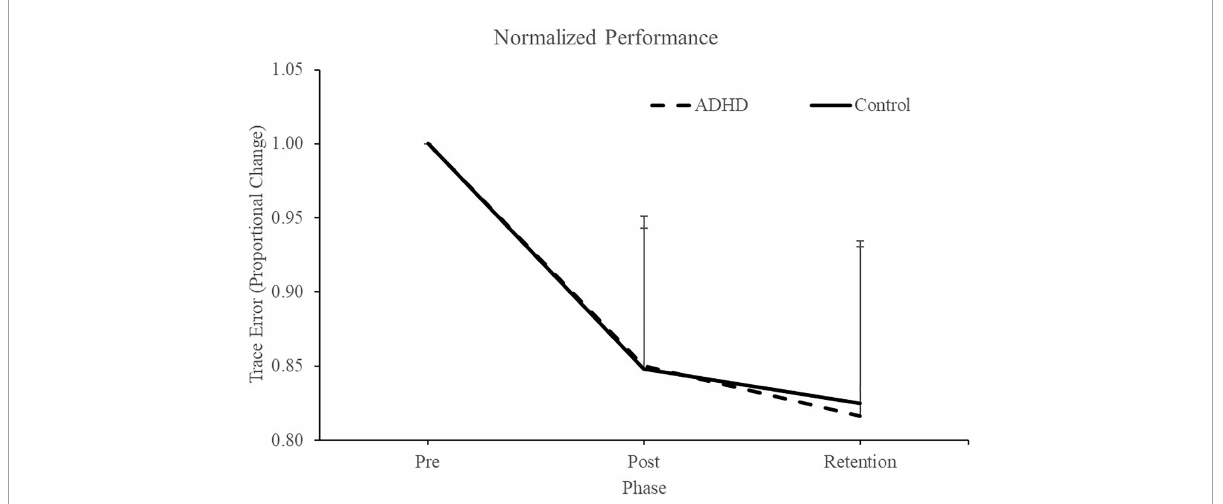
FIGURE3 Normalized performance scores for each phase when assessing trace error. Pre and retention measures have been normalized to each individuals baseline (pre) score. Retention data was collected 24-48 h after the pre and post data. ADHD scores are in the dashed line, controls are in the solid line. Values represent mean ± SD.